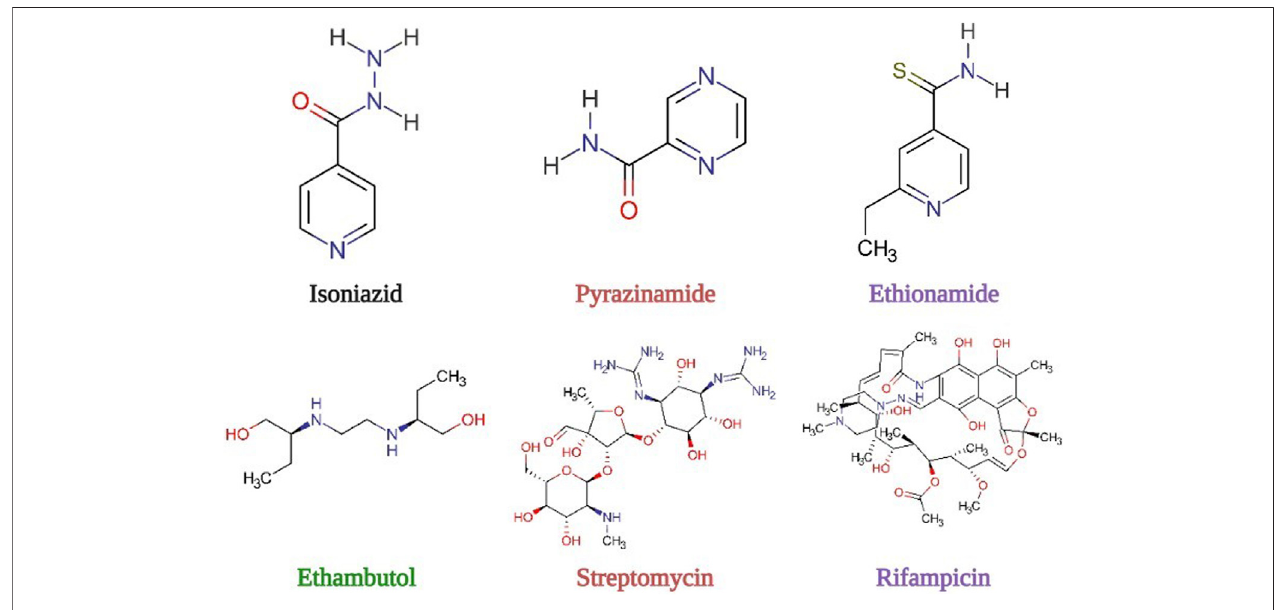
FIGURE 1 | Structures of fi rst-line drugs and ethionamide, a second-line drug.